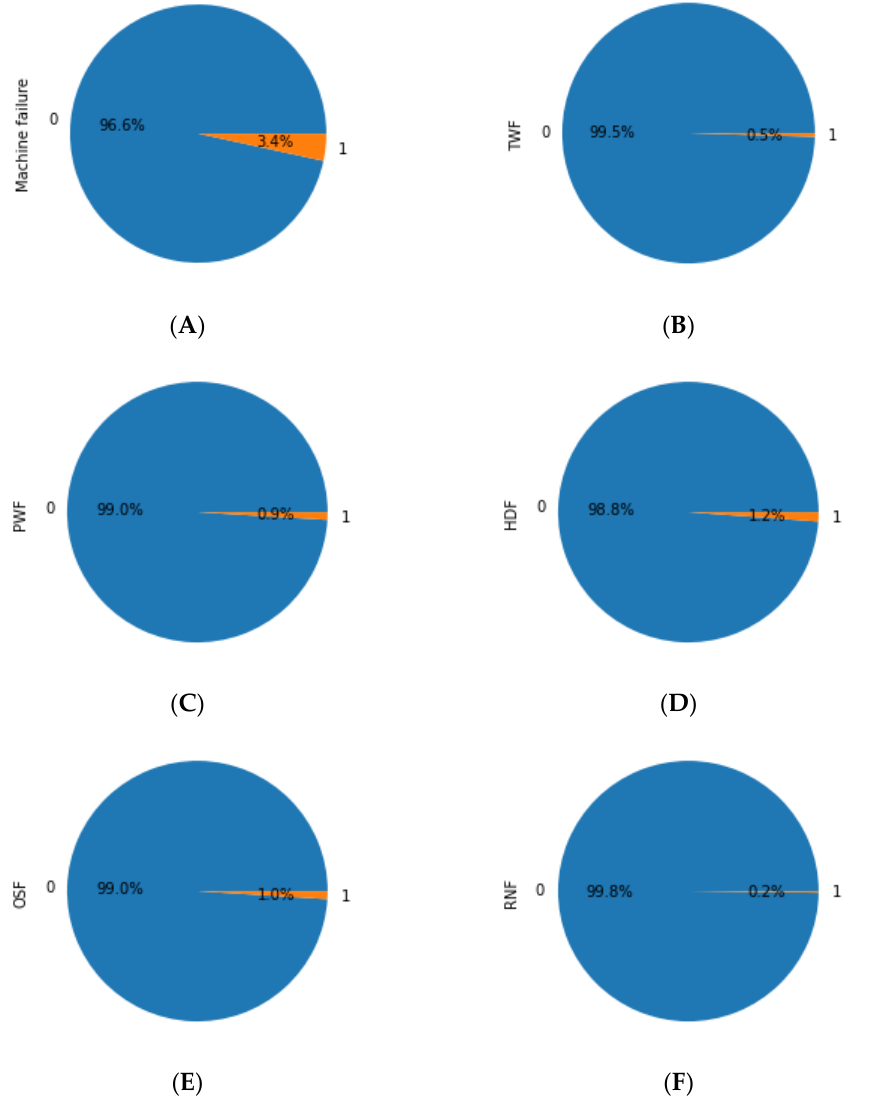
Figure 3. ( A ) Machine Failure Minority class 3.4%. ( B ) Tool wear failure (TWF) Minority class 0.5%. ( C ) Heat dissipation failure (HDF) Minority class 0.9%. ( D ) Power failure (PWF) Minority class 1.2%. ( E ) Overstrain failure (OSF) Minority class 1.0%. ( F ) Random failures (RNF) Minority class 0.2%.